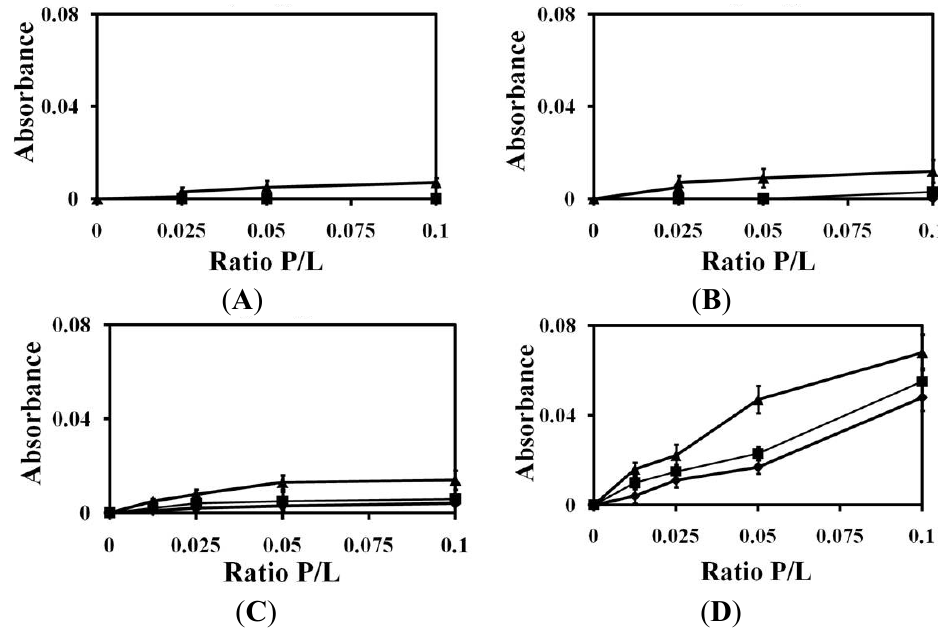
Figure 1. Large unilamellar vesicles (LUV) aggregation. Solutions containing various concentrations of peptide were added to a suspension of 400 μ M PC (diamonds), monitored based on changes in the absorbance of LUVs at 405 nm. ( A ) (KW) ; ( D ) (KW) ( C ) (KW) 4 5